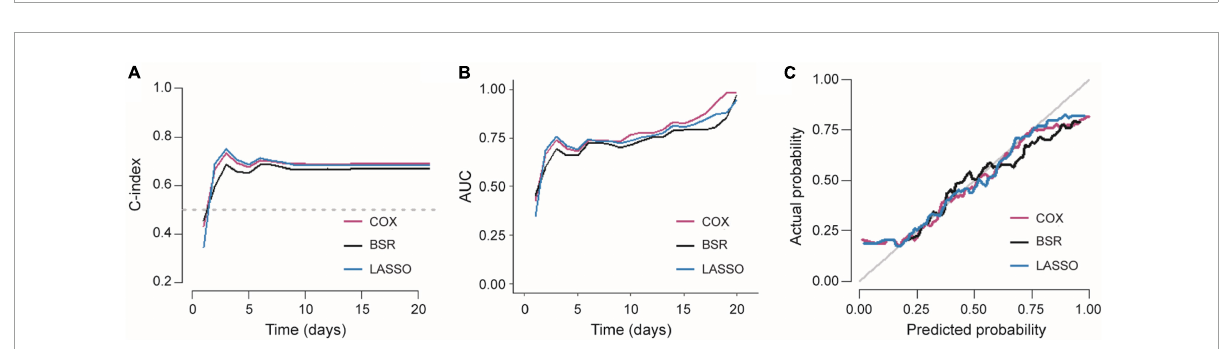
FIGURE5 Comparison of three Cox proportional hazard models. (A) C-index and (B) AUC of three models varied with time. (C) Calibration curves of three Cox proportional hazard